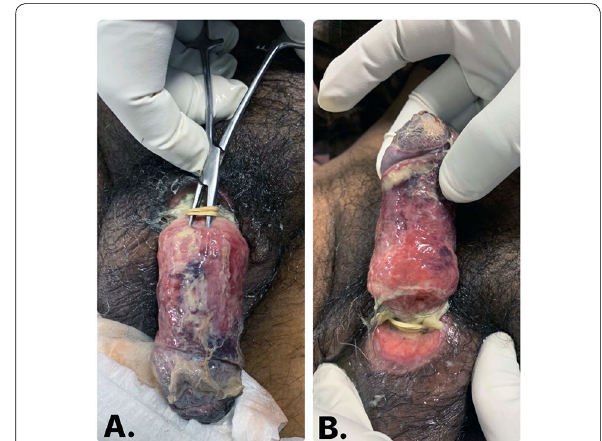
Fig. 5 a Glans and distal penile shaft were gangrenous, covered in slough with a constricting rubber band found at the base of the penis, buried in slough. b There was considerable loss of both corpora cavernosa and spongiosa at the site of constriction